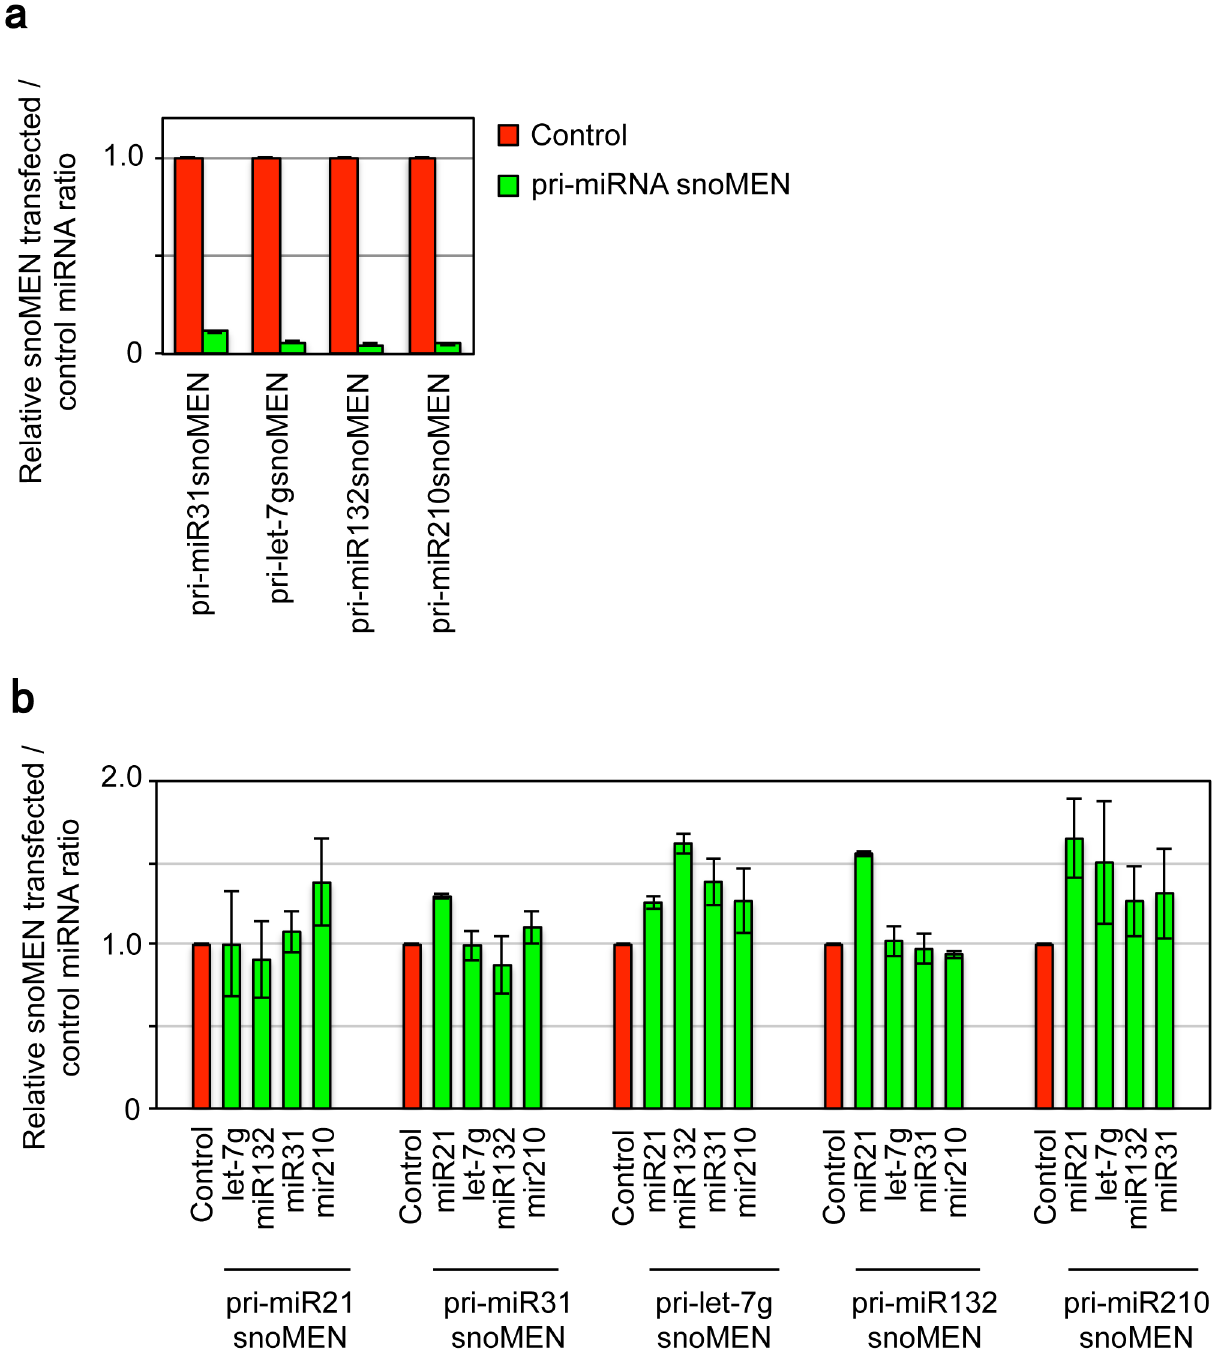
Fig 4. Specificity of miRNA knock-down using snoMEN vectors. ( a ) snoMEN vectors targeted to additional miRNAs. Total RNA from HeLa cells was harvested 24 hours after transfection and following cDNA synthesis, qPCR was performed using matured miRNAs targeted specific primers, i.e. miR31, let- 7g, miR132, miR210, and universal primer provided by the PerfeCta SYBR Green qPCR kit (Quanta Biosciences, see also methods) (Matured-miRNA, Green). U3 snoRNA was used as a control. Graph depicts mean and standard deviation from a minimum of 3 independent experiments. ( b ) Analysis of specificity of targeting miRNA knock-down using snoMEN vectors. qPCR was performed for 5 different miRNAs (miR21, miR-31, let-7g, miR132, miR-210) to check possible off target effects of snoMEN vectors targeting pri-miRNAs, i.e. pri-miR21 snoMEN, pri-miR31 snoMEN, pri-let-7g snoMEN, pri-miR132 snoMEN, pri-miR210 snoMEN. The graph shows average signal ratio for three independent experiments comparing specific targeted snoMEN with Control snoMEN transfection (Control, Red). Each signal was normalised by comparison with U3 snoRNA level.